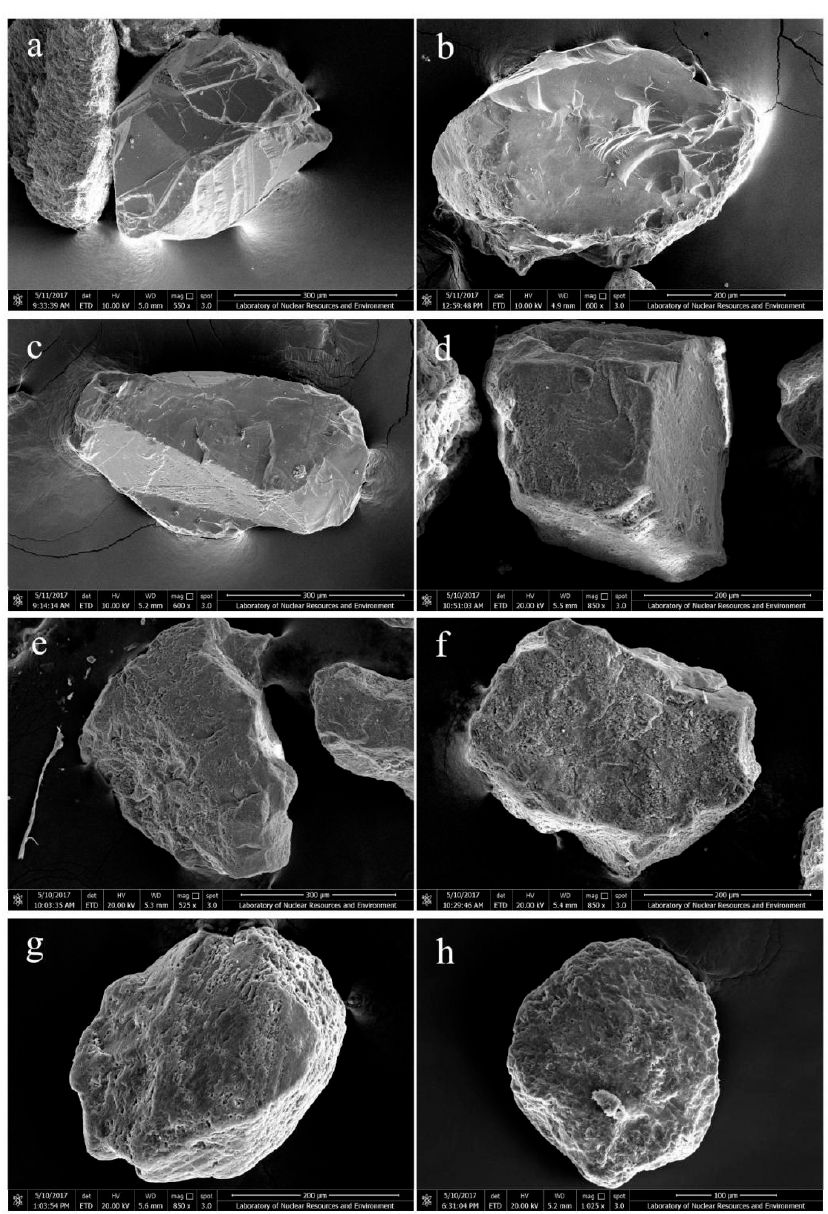
Figure 3. Typical quartz morphology in fault gouge from SEM. ( a , b ) angular grain, the surface is conchoidal fracture and straight crack (Ru type, TMS01); ( c ) subangular grain, the surface is subconchoidal fracture, local orange peel-like ( Ⅰ a type, TMS04); ( d ) subangular grain, the surface is orange peel-like ( Ⅰ b type, TMS07); ( e ) subangular grain, the surface is squamous-like ( Ⅰ c type, TMS01); ( f ) subangular grain, the surface is mossy-like ( Ⅱ type, TMS01); ( g ) spheroid grain, the surface is worm hole-like ( Ⅲ type, TMS06); ( h ) globular grain, the surface is pothole and coral-like ( Ⅳ type, TMS04).